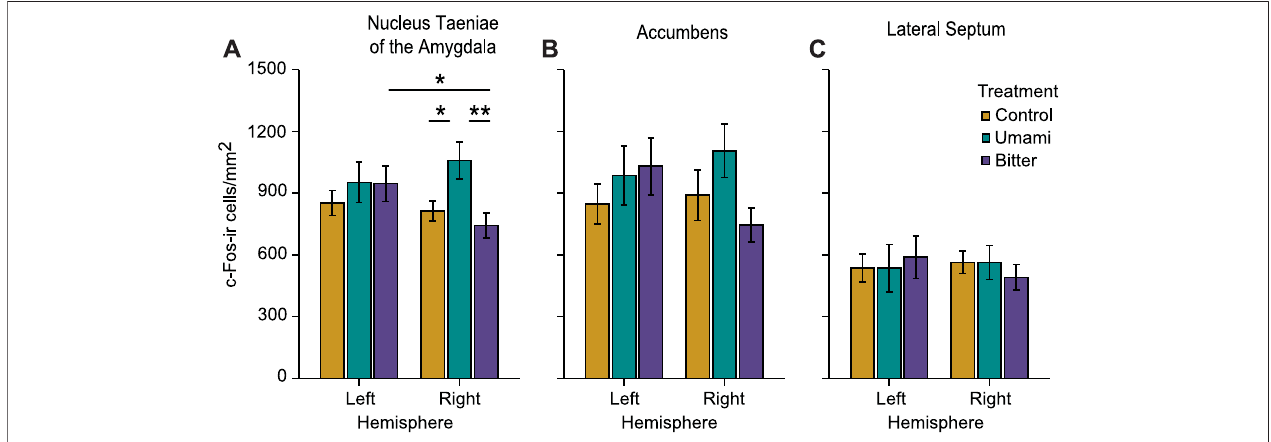
FIGURE 5 | Measured c-Fos-ir (immunoreactive) cell densities of the different treatments across regions of interest, in the left and right hemisphere. (A) nucleus taeniae of the amygdala, (B) nucleus accumbens, and (C) lateral septum. Bar plots indicate mean ± s.e.m. ( p p < 0.05, pp p < 0.01).